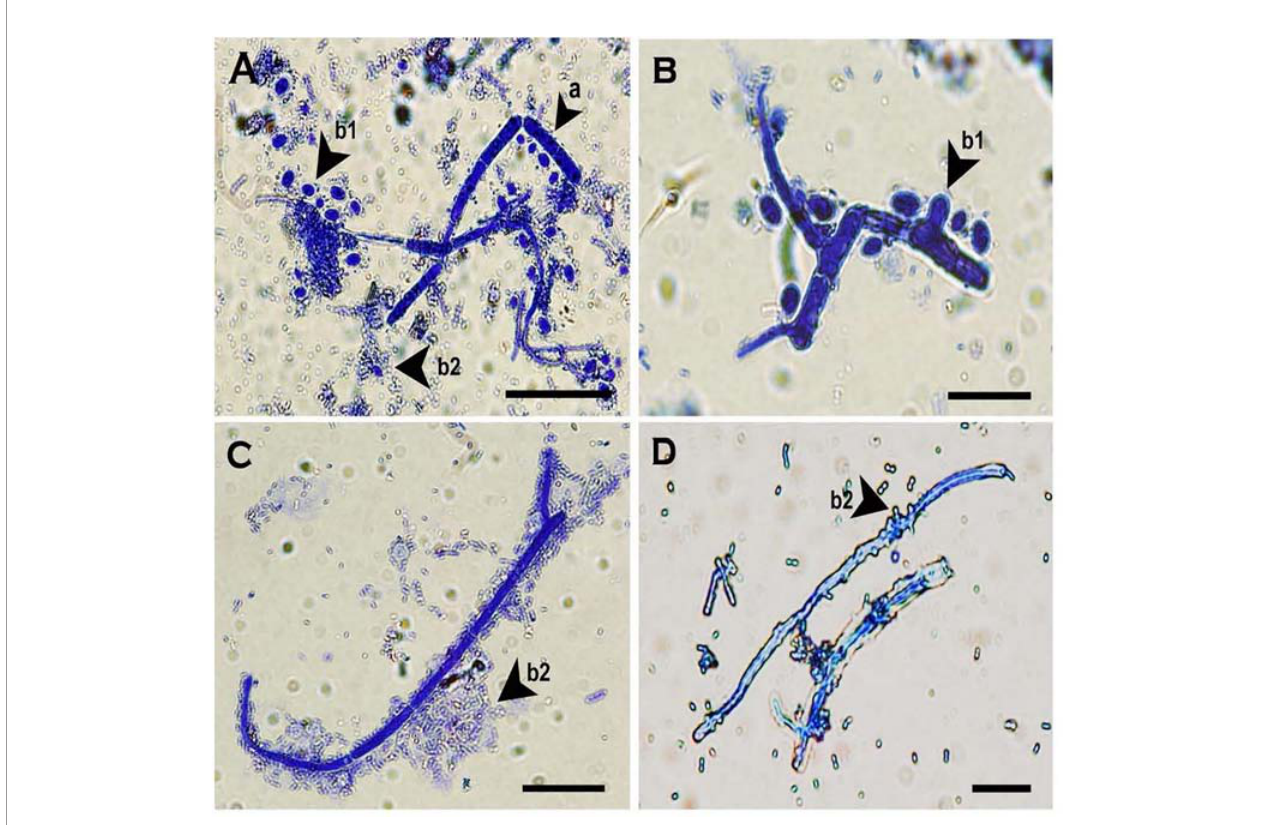
FIGURE 6 | Two morphologies of blastospores and arthrospores formed from Neopseudocercosporella capsellae multi-celled macroconidia suspended in sterile distilled water 24h post-inoculation. (A) Multi-celled macroconidia with meso-blastopores (b1), micro-blastospores (b2) and an arthrospore (a). (B) Multi-celled macroconidium producing meso-blastospores (b1) (arrow shows a meso-blastospore bud raised adjacent to the septa). (C) Multi-celled macroconidium with micro- blastospores (b2). (D) Micro-blastospore (b2) formed from multi-celled macroconidia (arrow shows buds of micro-blastospores). Scale bars (A, C) 20µm; (B, D)